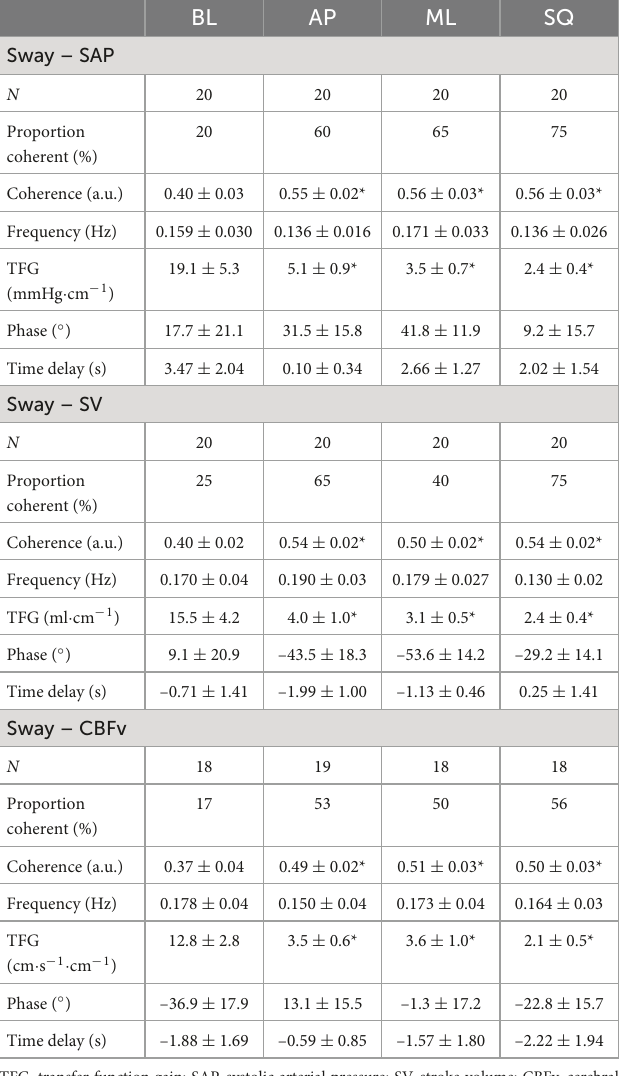
TABLE 2 Cross-spectral analysis of sway and cardiovascular parameters. BL AP